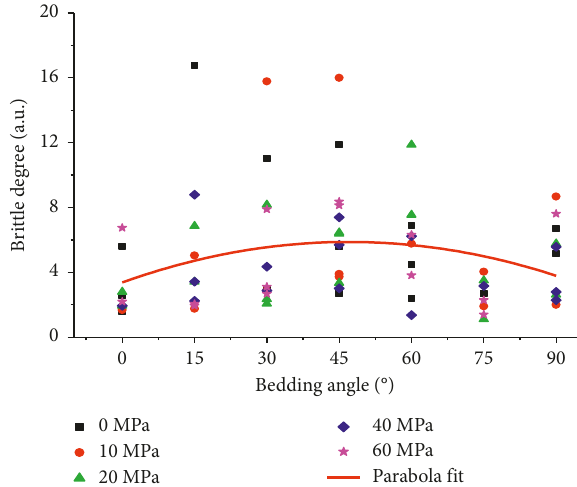
Figure 15: Relationship between brittleness and bedding angle.